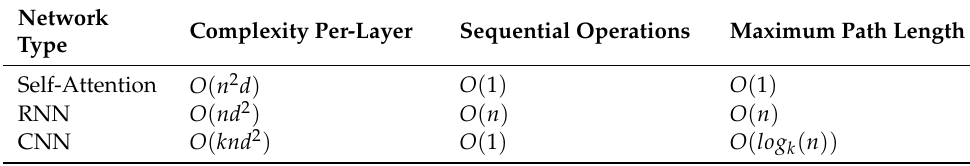
Table 2. Comparison of different network